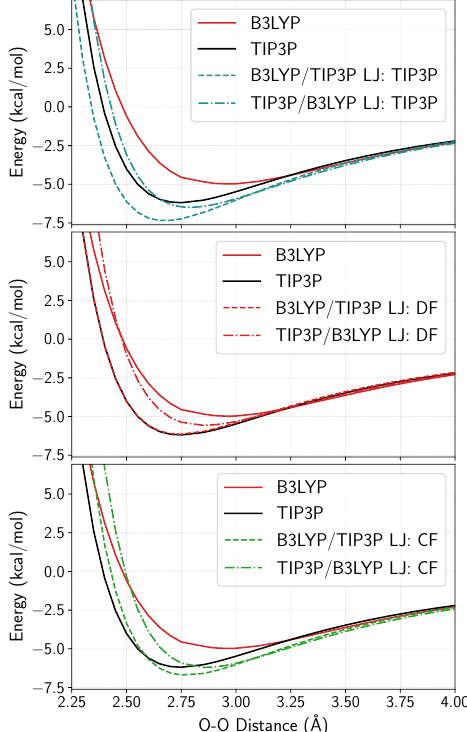
Figure 2. Water dimer binding curves (counterpoise corrected), calculated using LJ parameters from: TIP3P ( top ); the dimer fit ( middle ); and the cluster fit ( bottom ). The starting geometry is obtained from the S22 database, where the water dimer was optimized using CCSD(T) [43], and all other intramolecular geometries are kept constant while scanning the O-O